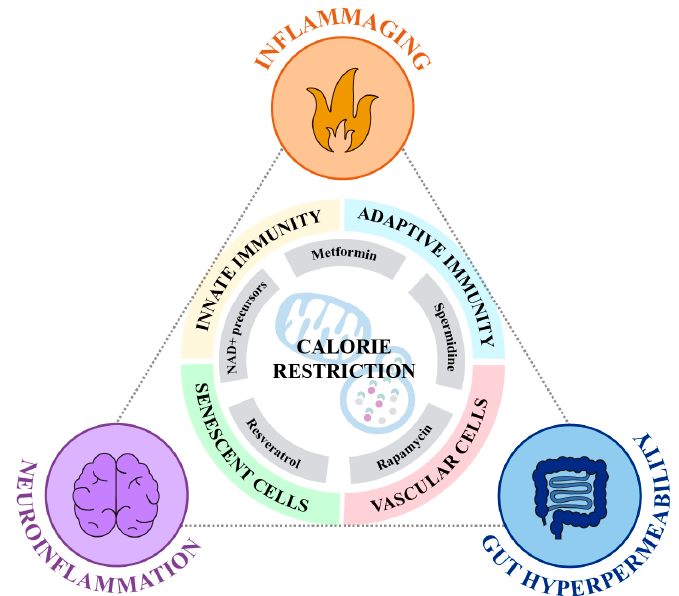
Figure 2. Calorie restriction and CR mimetics modulate inflammaging, neuroinflammation and gut permeability. Calorie restriction and its mimetics act on autophagy and mitochondrial function to prevent the activation of inflammatory pathways. Its anti-inflammatory role occurs both at the systemic (inflammaging) and at the local level (i.e., neuroinflammation, and enhanced gut barrier permeability).